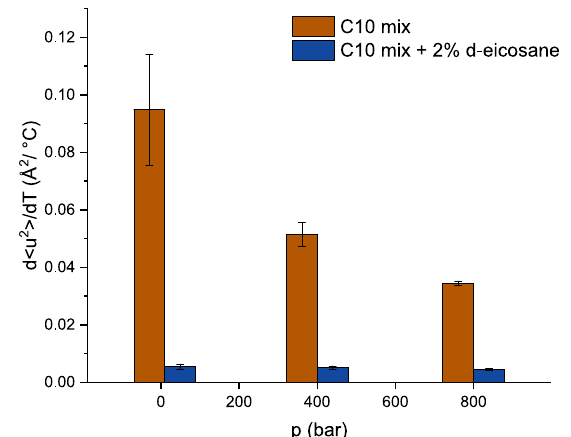
Fig. 5 Pseudo-force constants. Histogram comparing the derivative of the MSD data vs temperature assuming a simple linear model. Note that the value of C10 mix at p = 10 bar is a likely underestimation. Each value is shown with its error from the linear